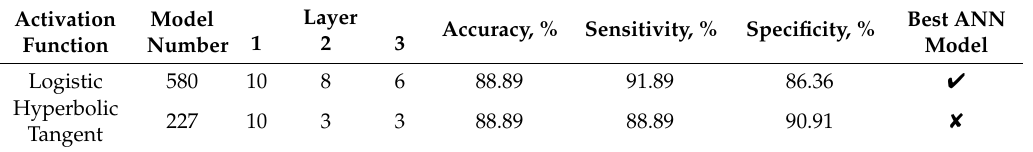
Table 15. Summary of best ANN models of logistic and hyperbolic tangent activation functions.